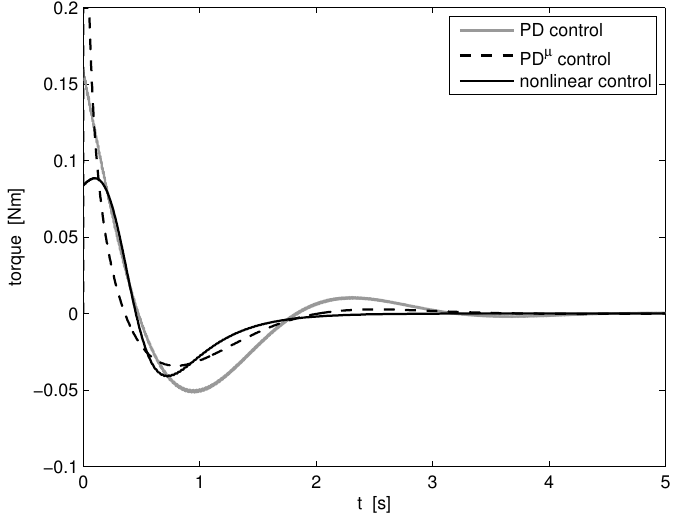
Figure 8. Motor torque, comparison with PD and PD µ